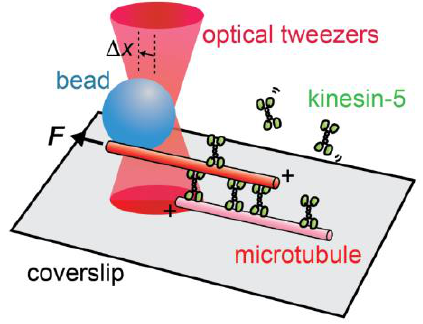
Figure 6. Schematic for the “mini-spindle” assay. Optical trapping and TIRF (total internal reflection fluorescence) microscopy are combined to examine forces generated by kinesin-5 sliding two microtubules apart.